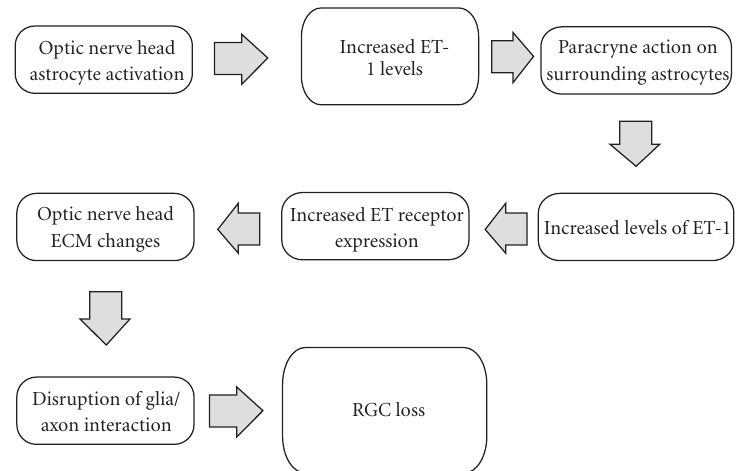
Figure 3: Potential mechanism of endothelin (ET) and ET receptor-mediated actions causing retinal ganglion cell (RGC) loss. Optic nerve astrocytes may become activated via ET actions, leading to extracellular matrix (ECM) changes in the optic nerve head and eventual RGC loss. Figure adapted from Chauhan BC